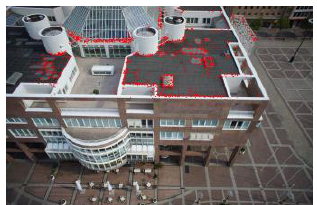
Figure 5. Automatically detected coplanar points in